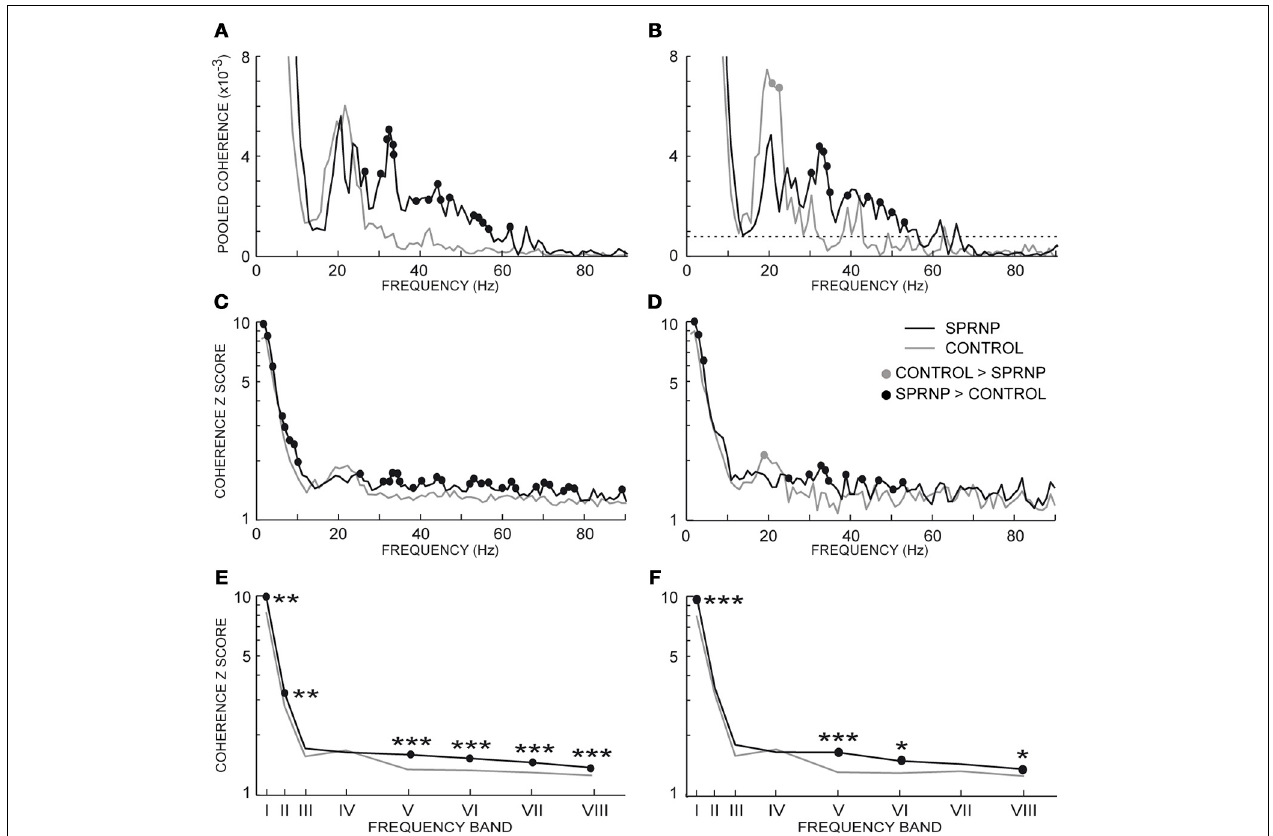
FIGURE 5 | Pooled coherence estimate spectra (1Hz bin) for all MU pairs (A), and the subsets of 45 pairs (B, dotted line: coherence significance limit); (averaged coherence Z scores per 1Hz-bin for all MU pairs (C), and the 45 pairs subsets (D); averaged coherence Z scores within 8 frequency bands for all MU pairs (E),